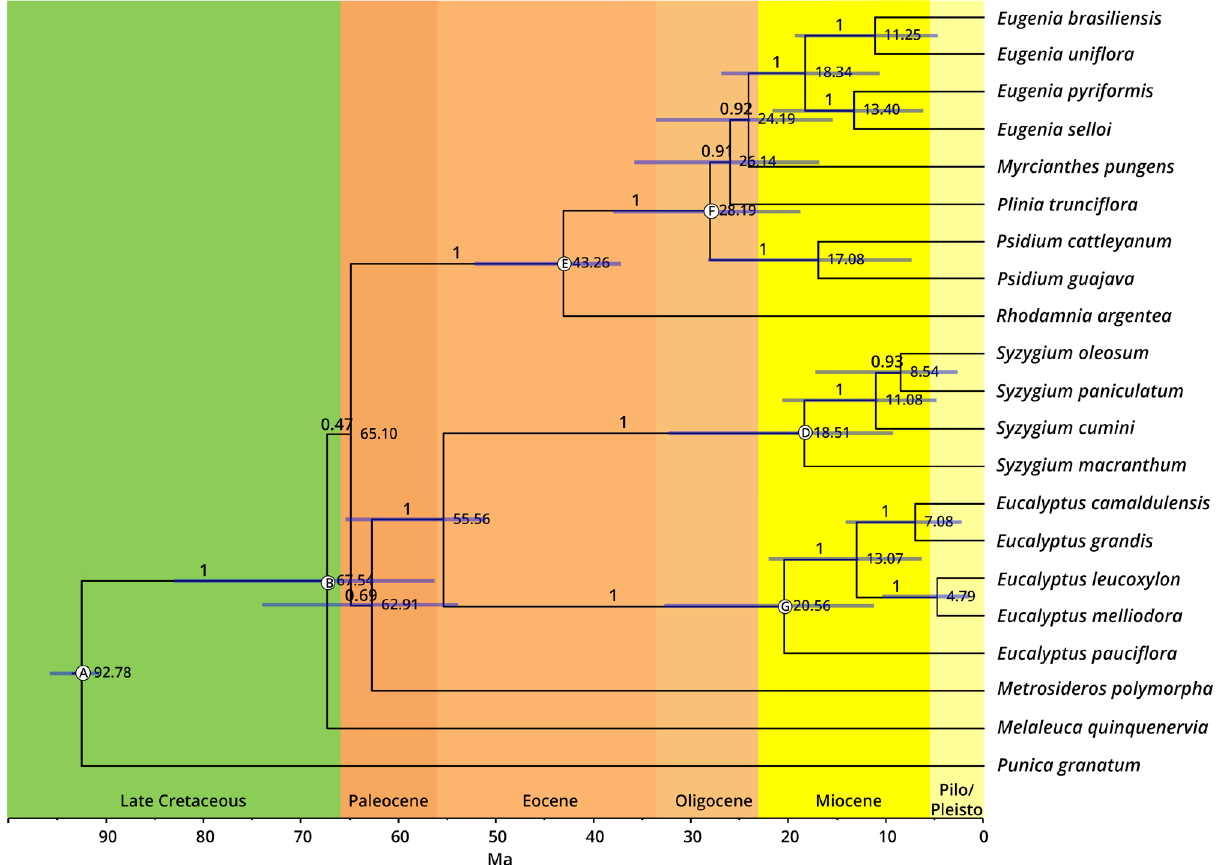
Figure 5 – Chronogram of Myrtaceae species based on the five nuclear marker genes supermatrix. Posterior probabilities for each node are indicated and nodal ages represent the median posterior estimates. Branch lengths are scaled according to time and blue bars represent the 95% highest posterior density interval of age estimates. Calibrated nodes are labelled from A, B, D-G corresponding to fossil calibration detailed in Table S5.